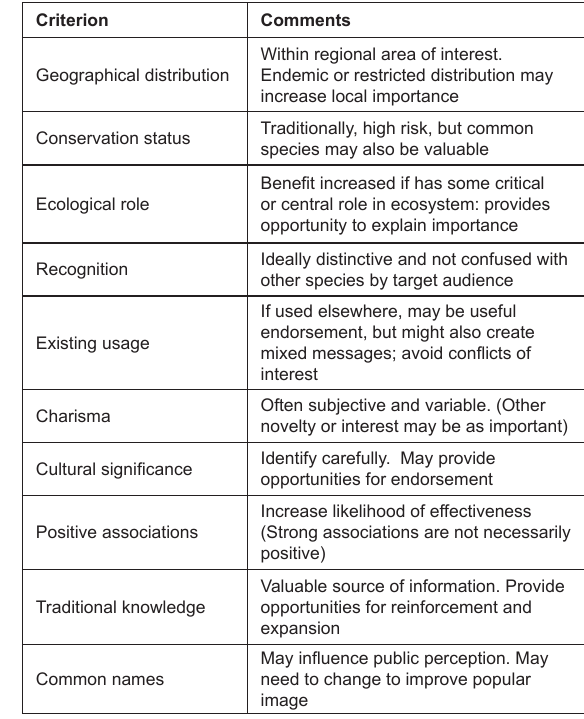
Table 1. Ten criteria for consideration in choosing effective flagship species (after Bowen-Jones & Entwistle